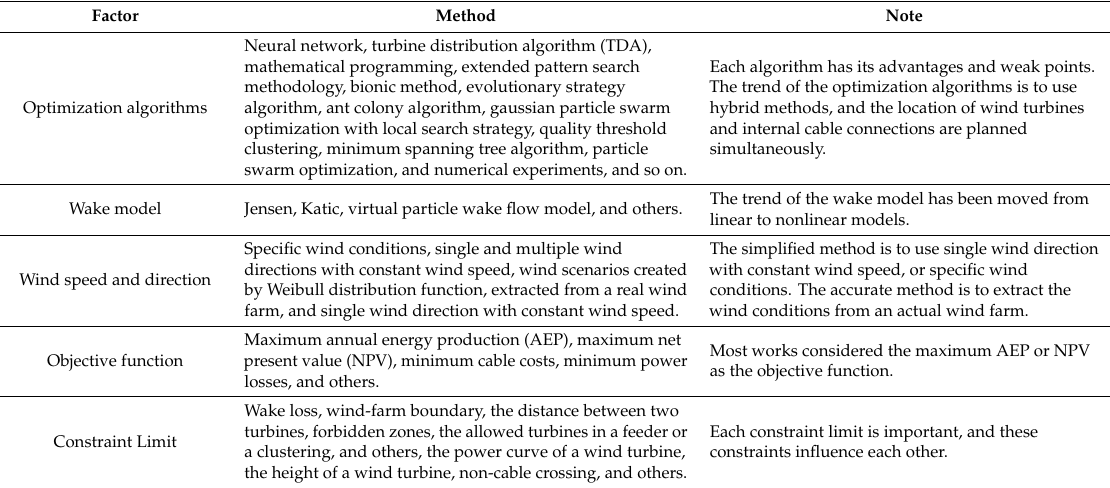
Table 1. Main factors that strongly influence the design of an o ff shore wind